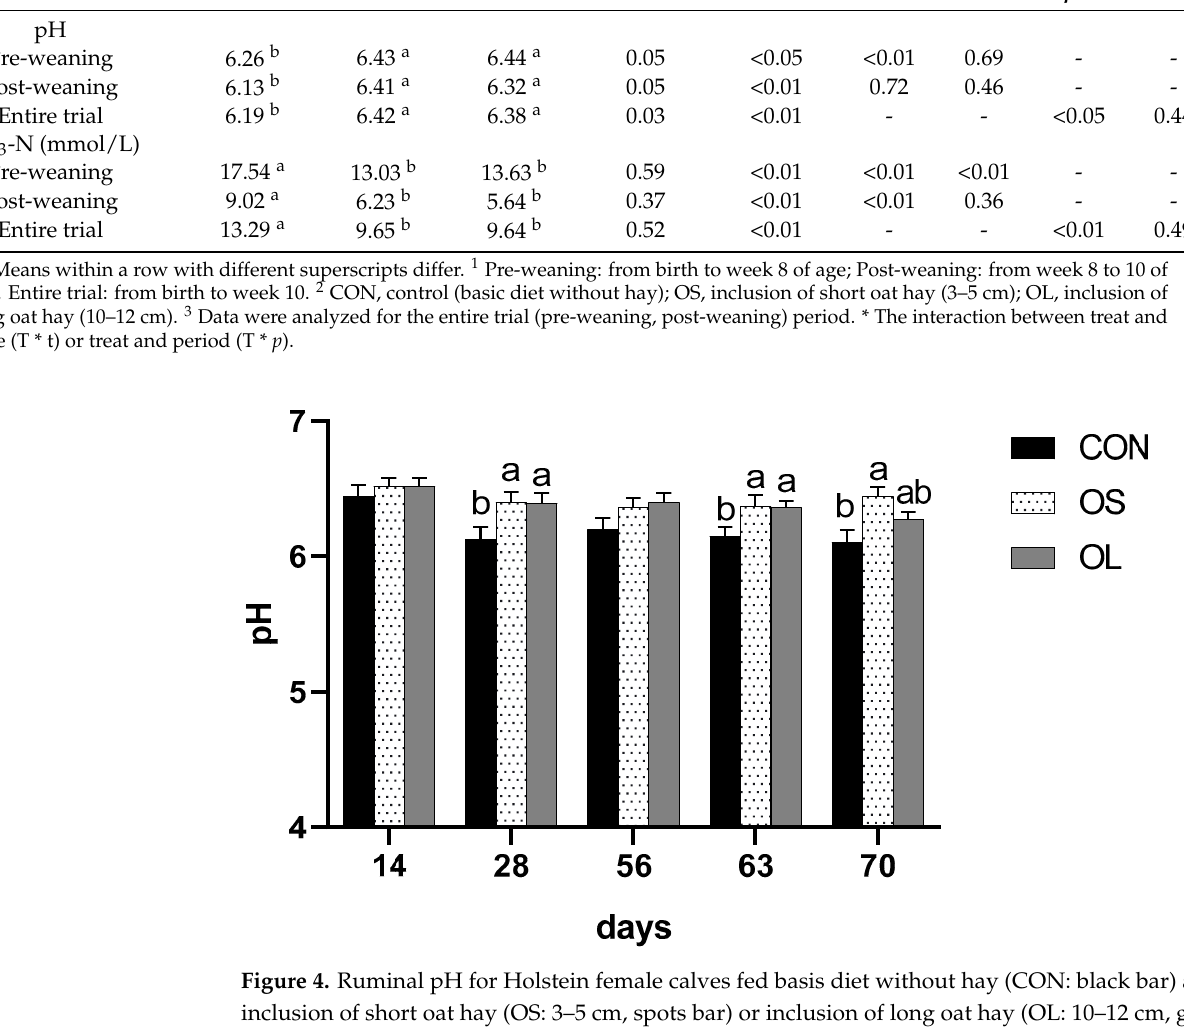
Table 3. Effects of different lengths of hay supplementation on calf’s rumen pH and NH 3 -N at different stages 1 .